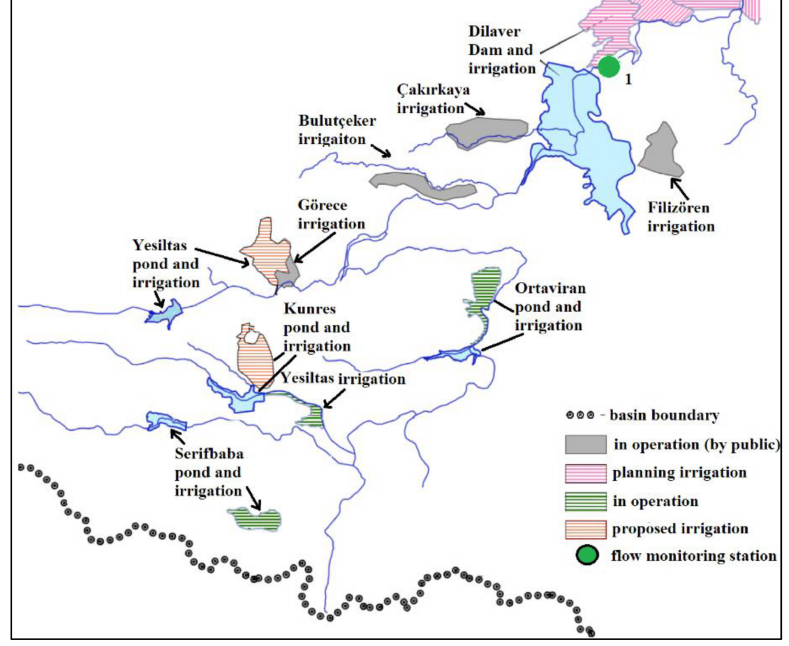
Figure 4. Demonstration of upstream facilities for the flow monitoring station